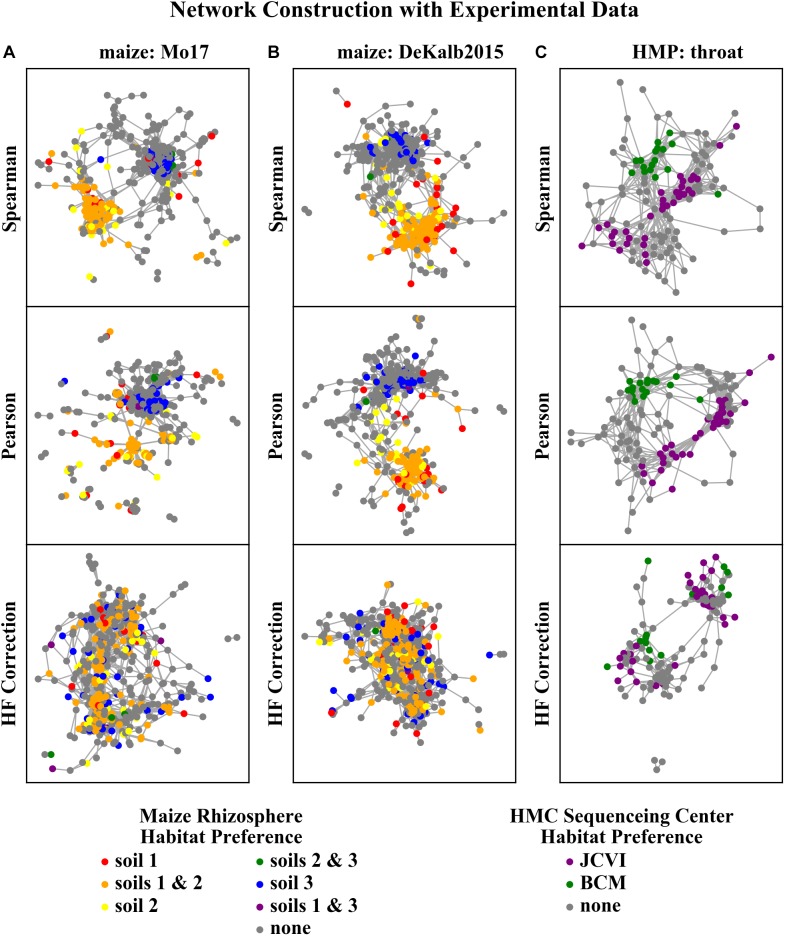
Rhizosphere microbiome correlation networks constructed with different correlation detection algorithms for (A) maize Mo17, (B) maize DeKalb2015, and (C) HMP throat microbiome data sets. Each node in the network represents a single ASV/OTU. ASVs/OTUs are colored based on their habitat preference as assessed by the independent differential abundance analysis.